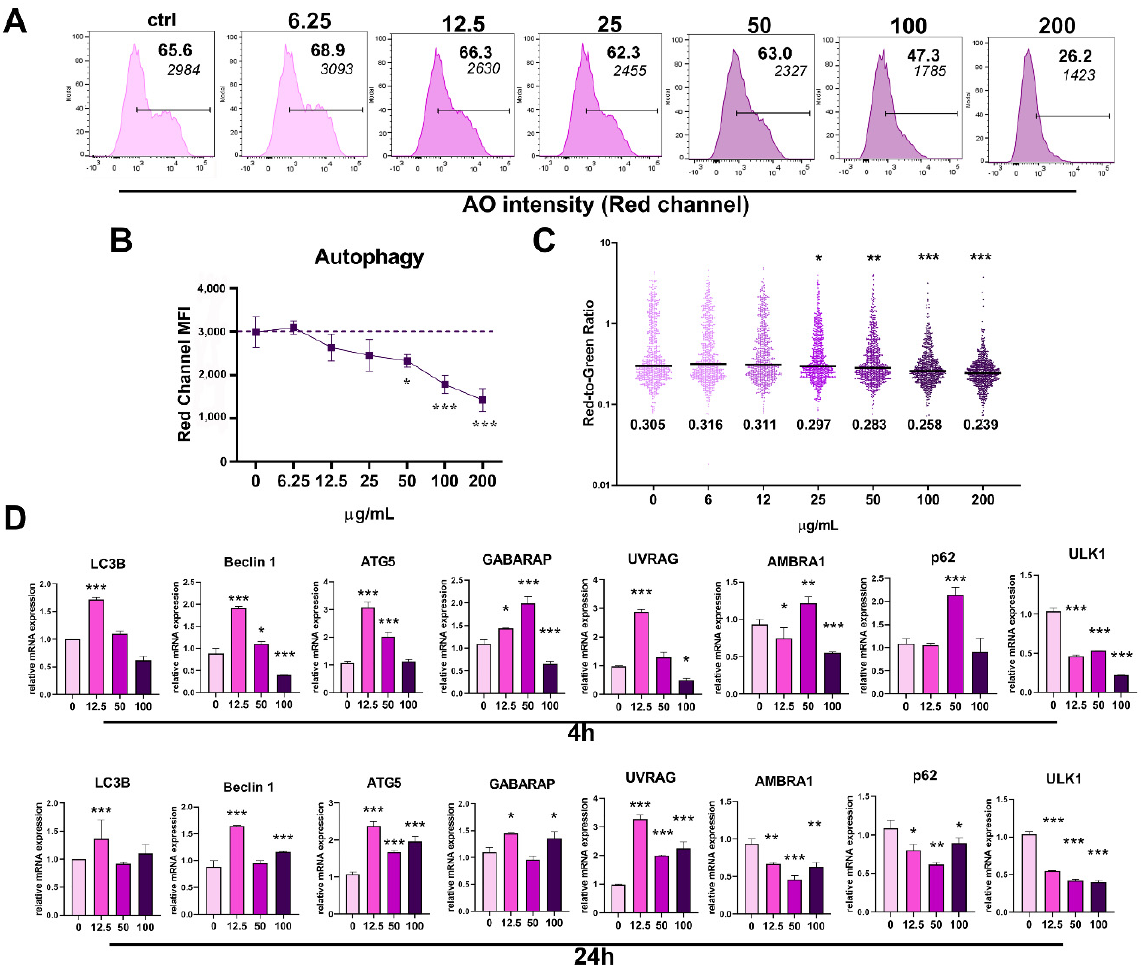
Figure 3. The effects of PoPEx on autophagy in PBMC. Autophagy in PBMC was determined after the cultures of PBMC (3 × 10 5 /well) were treated with increasing doses of PoPEx (6.25–200 µ g/mL) for 24h, by acridine orange (AO) staining and flow cytometry analysis. ( A ) A representative analysis of red fluorescence AO intensity is shown, along with the summarized data ( B ). ( C ) The red to green fluorescence ratio was determined by dividing FL2 channel MFI with FL1 channel MFI in AO-stained samples (wo compensation) for each gated event in FCS files. ( D ) Relative mRNA expression for indicated autophagy-regulatory genes in PBMC treated with 12.5 µ g/mL, 50 µ g/mL, or 100 µ g/mL for 4 h or 24 h, was determined by qPCR using the 2 − ∆∆ Ct method, and β -actin as a reference gene in the treated groups. The summarized data ( B ) are shown as mean ± SD from four independent experiments, whereas data in ( D ) is shown as mean ± SD from three independent